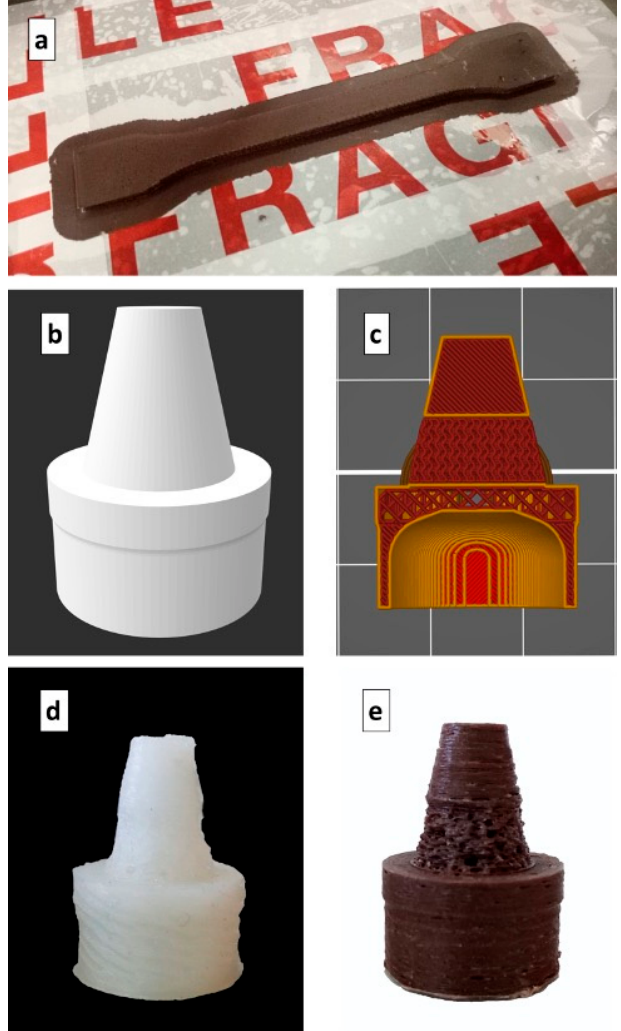
Figure 2. ( a ) Tensile specimen printed with the pozzolan composite. ( b ) 3D model of the prototype for precision irrigation. ( c ) Longitudinal section of the sliced prototype. ( d ) Prototype sample 3D printed with neat HDPE. ( e ) Prototype sample 3D printed with composite at 20% pozzolan.